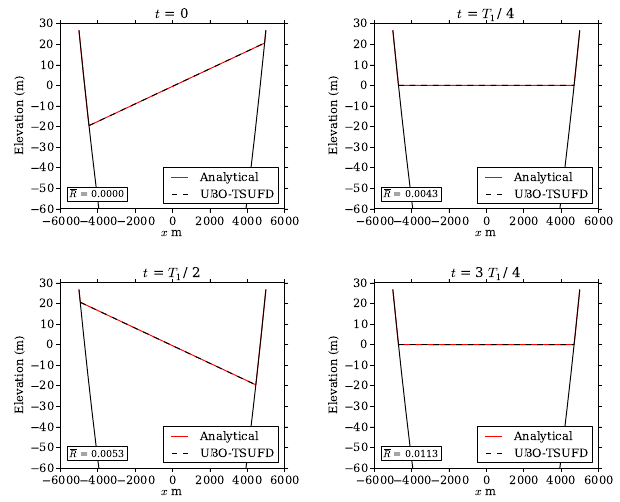
Fig. 9. Benchmark n. 2: cross sections of the sea planar surface taken at each quarter of the period T 1 , i.e. equal to 470s. After a full oscillation of the water surface, the agreement between analyt- ical and numerical results is still very satisfactory, despite of the numerical noise shown in Fig. 12. The values of ¯ R are the mean residuals calculated over the entire domain in m. They tend to in- crease along with the simulation